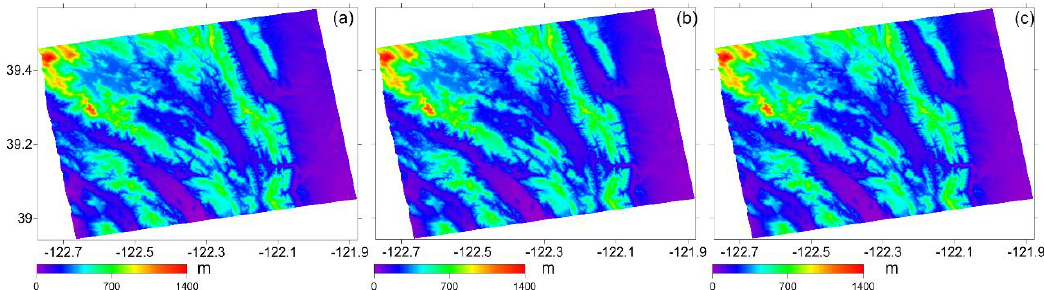
Figure7. Interferometric synthetic aperture radar (InSAR) DEM ( a ) without atmospheric correction, ( b ) with Shirzaei’s atmospheric correction method, and ( c ) with MRWCA atmospheric correction.